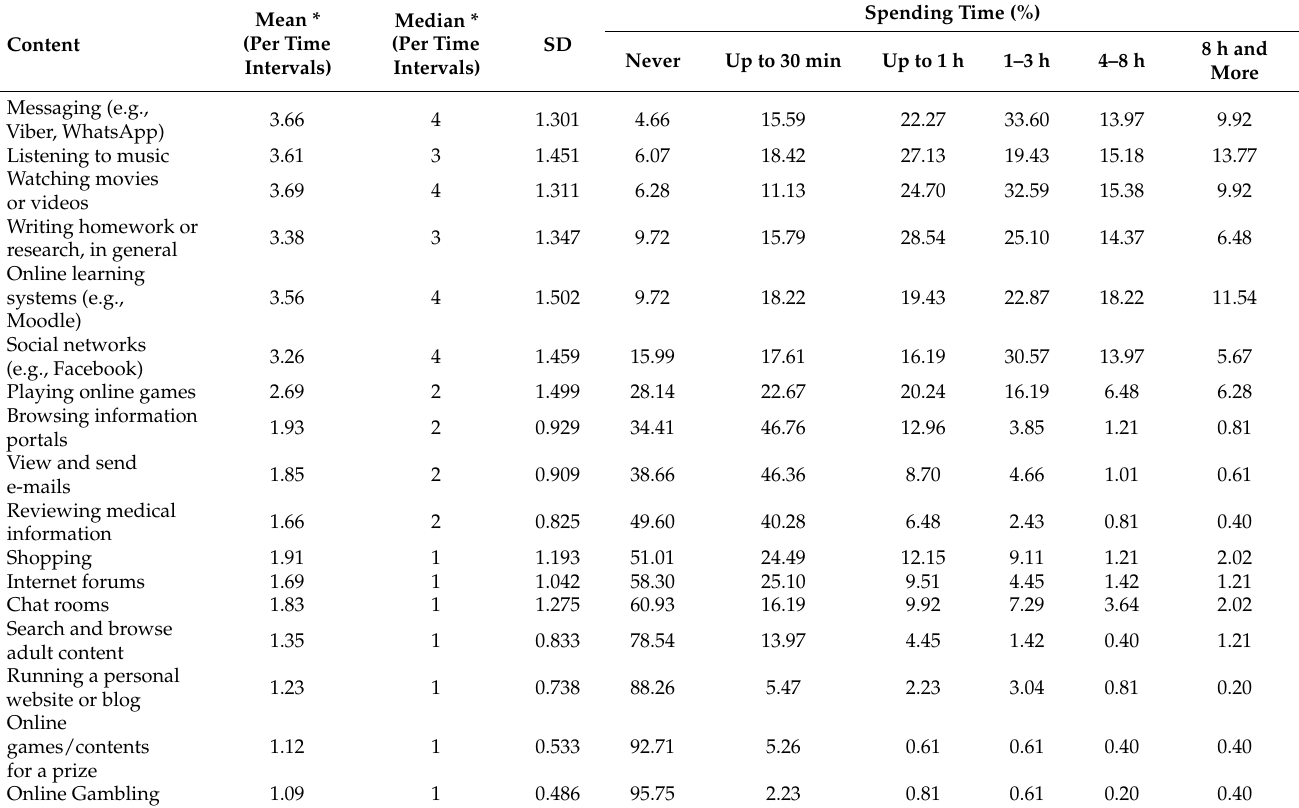
Figure 1. Comparison of time using the Internet before and during the COVID-19 pandemic. Table 2. Daily use of different online contents via